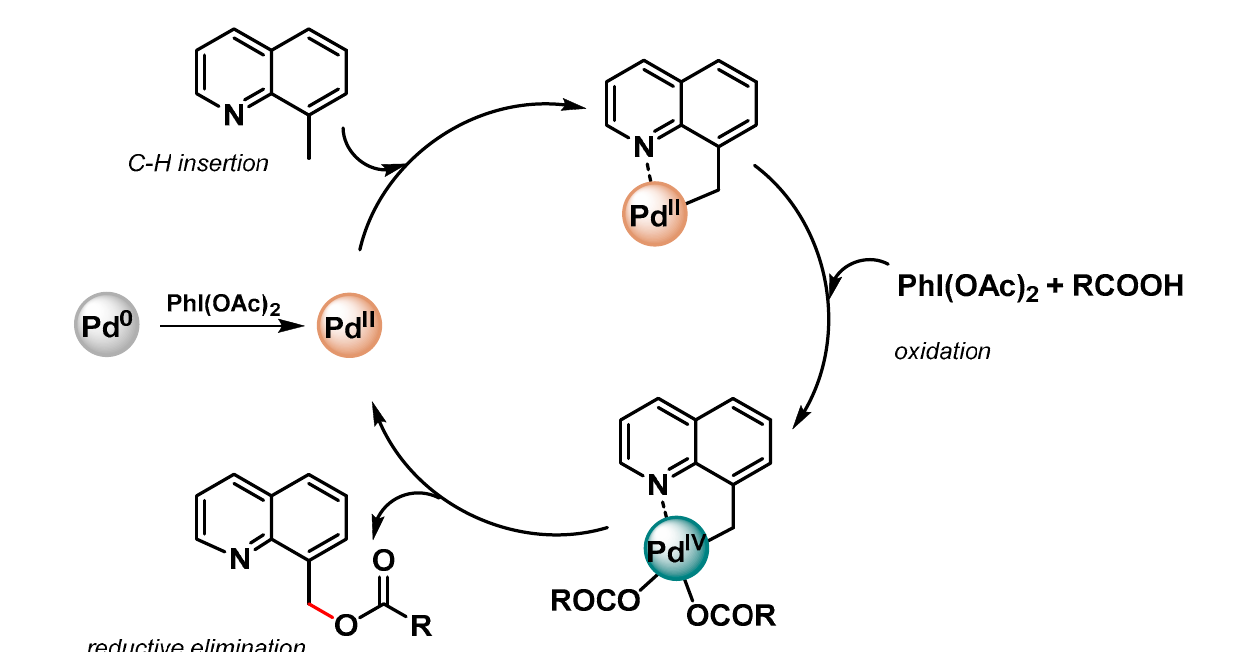
Scheme 11. Proposed mechanism for N-chelation-directed Pd(II)/Pd(IV) C–H